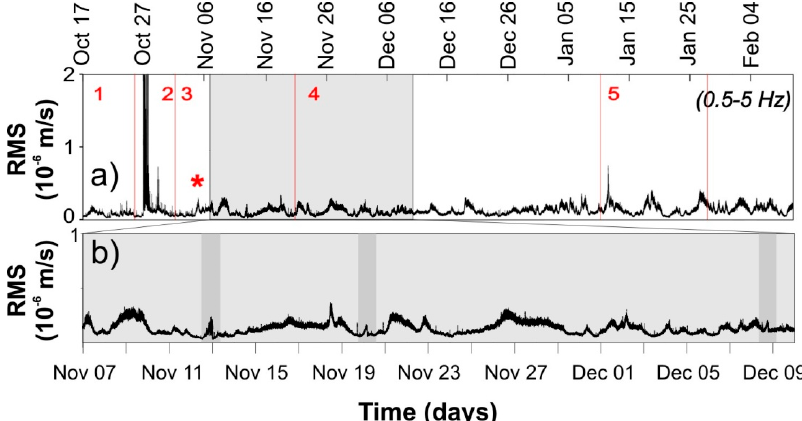
Figure 3. ( a ) RMS computed on the background seismic signal filtered within 0.5–5 Hz. Vertical